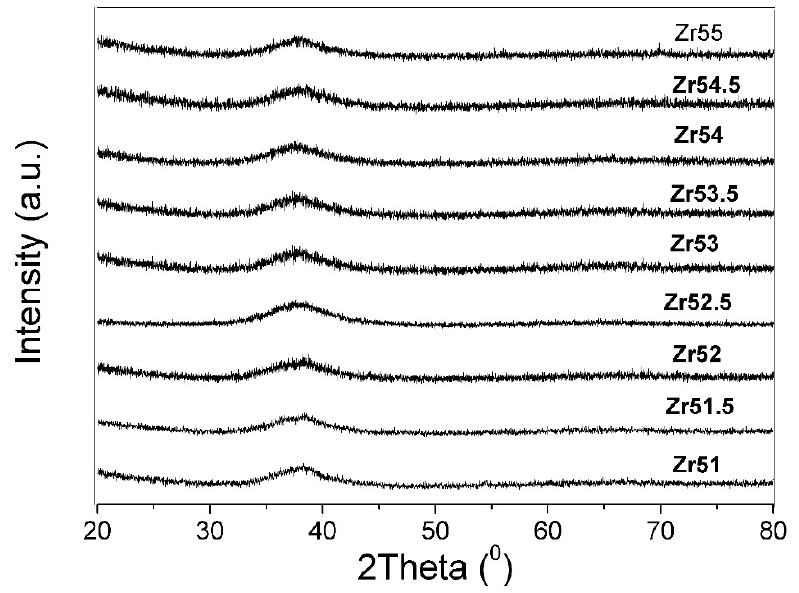
Figure 1. XRD patterns for Φ 8 mm Zr-Al-Ni-Cu bulk metallic glasses.